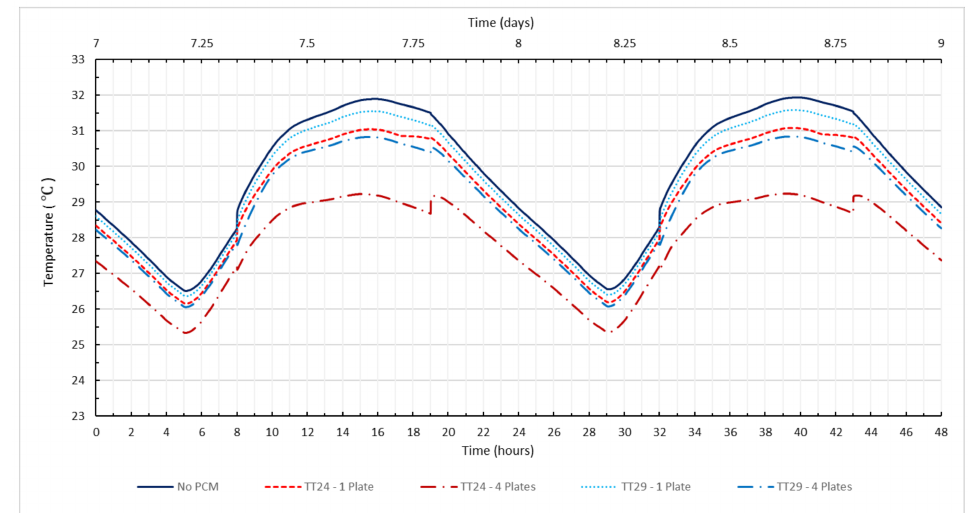
Figure 12. Indoor temperatures for the high inertia room and normal climate, with forced convection at the place surfaces. Table 5. Impact of the PoDIT system upon indoor air temperature of the reference room, for several configurations and conditions, considering the reference normal weather. Natural Convection Forced Convection TT24 TT29